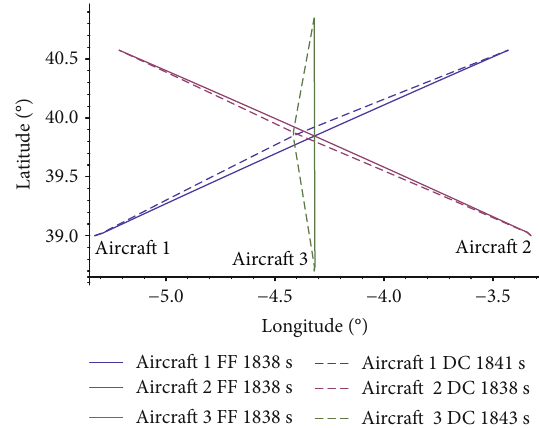
Figure 9: Experiment 2. Horizontal pro fi les with (DC, dashed lines) and without (FF, solid lines) distance-based separation